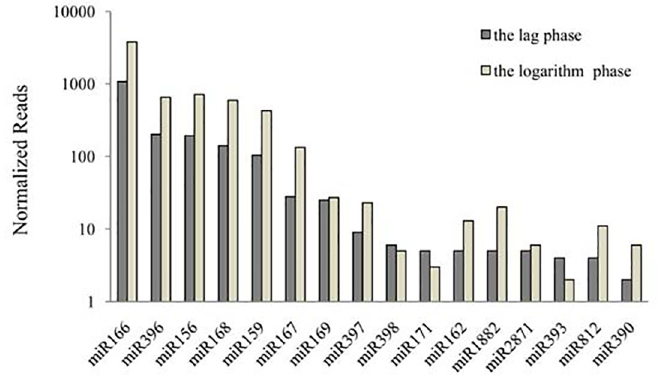
Fig 3. Expression abundance of miRNA families in two growth phases in A . catenella . X-axis represents the known miRNA families, Y-axis represents the normalized expression level of each miRNA